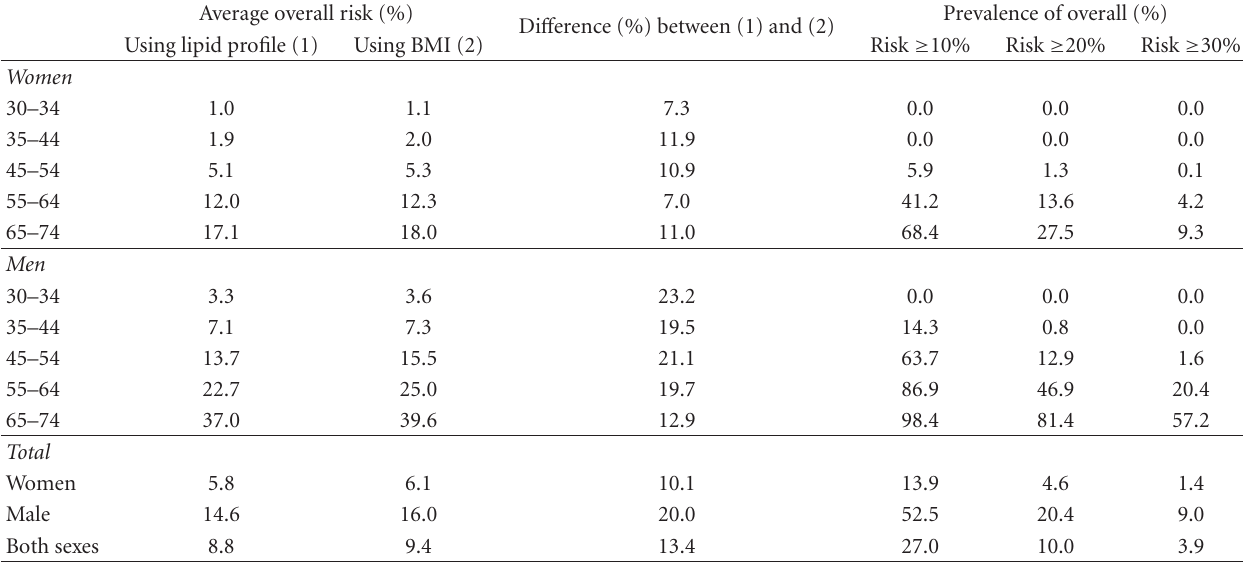
Table 3: Average estimated overall CVD 10-year risk using Framingham general risk score (either using lipid profile or BMI) and prevalence of high overall risk in a studied population of Vietnamese adults, stratified by sex and age